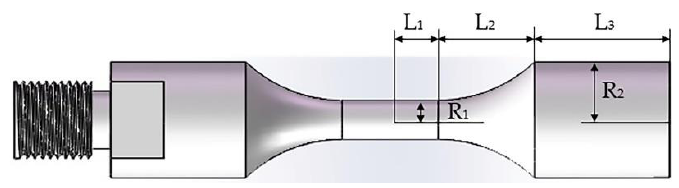
Figure 7. Dimensioned drawing of the sample simulation model.